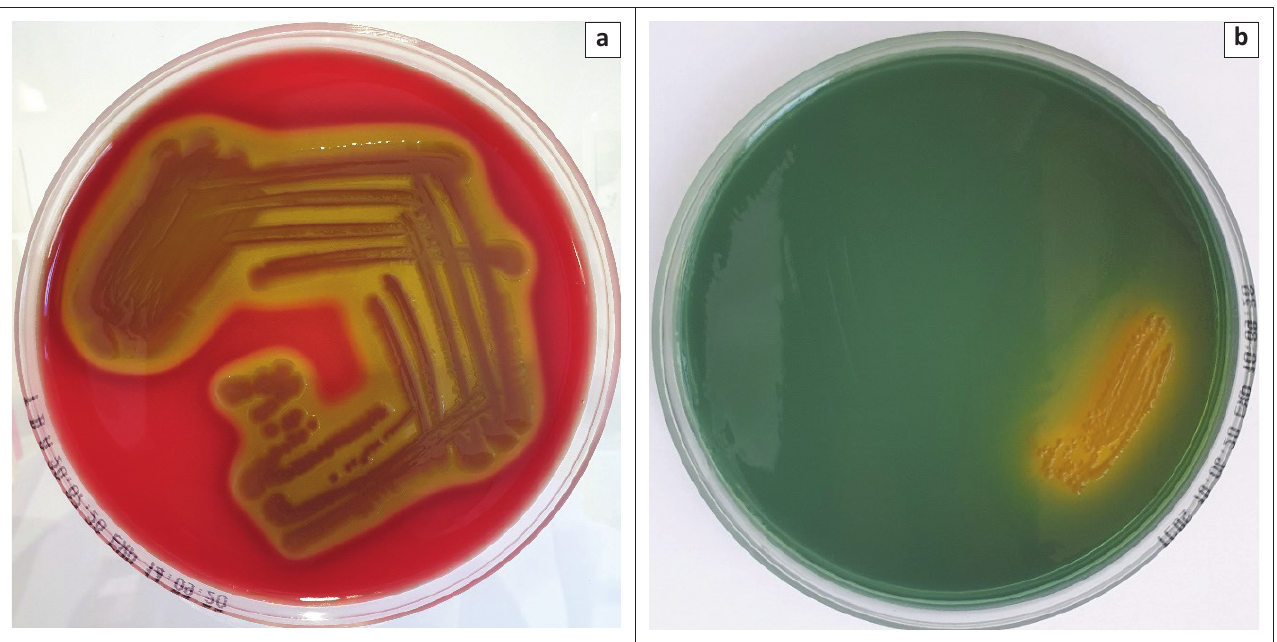
FIGURE 2: (a) Characteristic greyish-brown colonies of Vibrio cholerae with a wide zone of beta haemolysis on tryptose blood agar plate after overnight incubation at 35 °C in a 5 % CO enriched atmosphere; (b) Thiosulphate-citrate-bile salts-sucrose agar with yellow colonies, in keeping with Vibrio cholerae after overnight incubation at 35 °C 2 in ambient